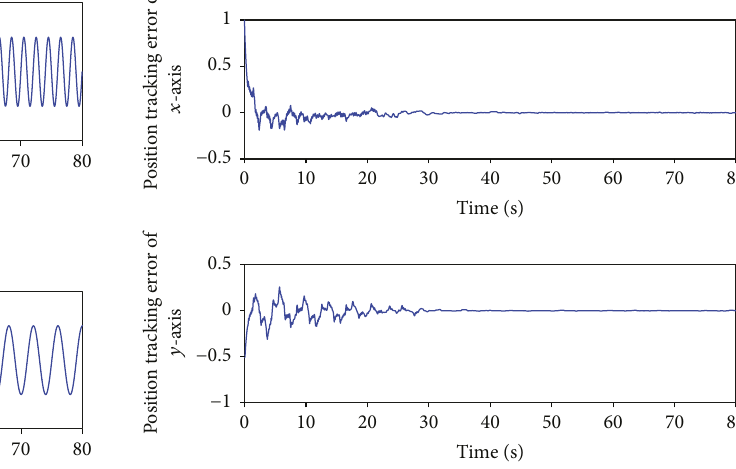
Figure 5: Tracking error using ABFONTSMC-FNN.